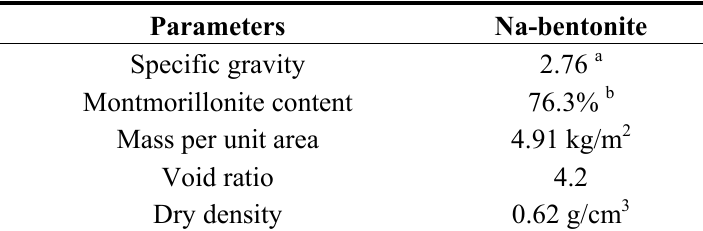
Table 1. Properties of Na-bentonite used in the